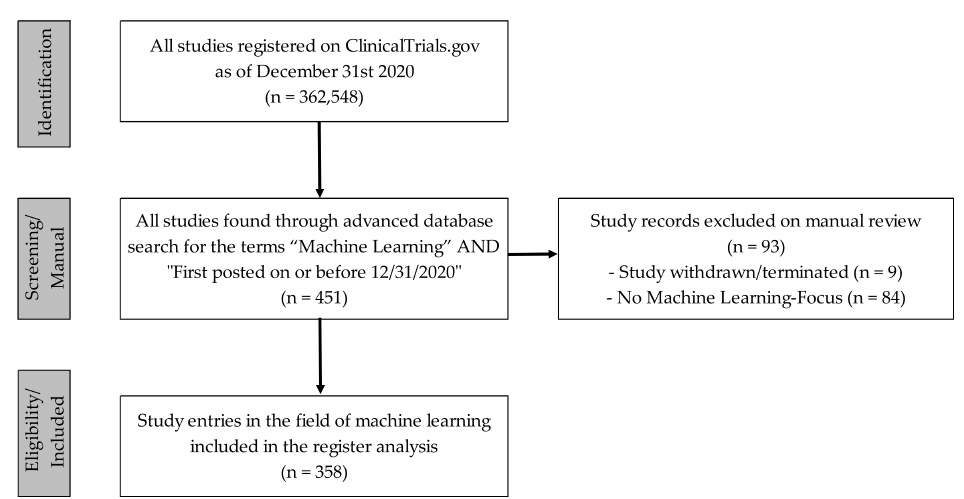
Figure 1. Flowchart for the selection procedure of the ML-related clinical study entries considered for the quantitative registry analysis. Source: Own figure based on the evaluation of the ClincalTrials.gov dataset